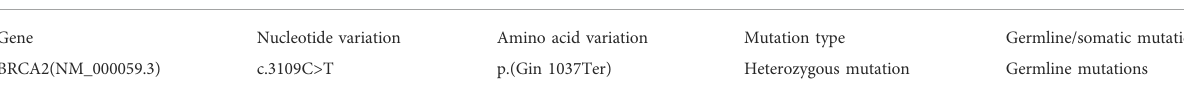
TABLE 1 Detection result of BRCA1/2 germline mutations in a blood